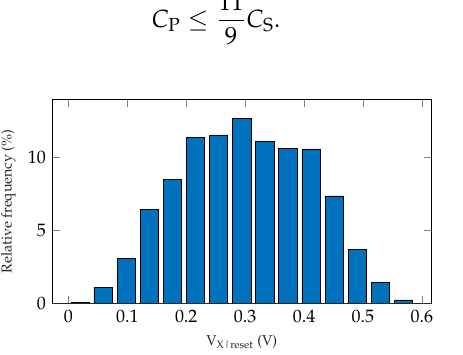
Figure 9. Distribution of V X|reset .